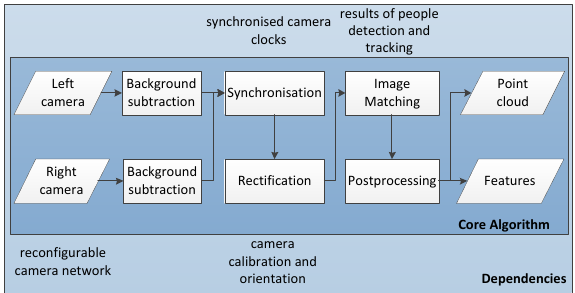
Figure 2: Imaging geometry in monocular and stereoscopic case. Figure 1: Core algorithm and external dependencies. offset between the images would lead to different poses of the al., 2009), classification of observed people into either salient or person in the left and right frame hindering image matching or unremarkable and dynamical reconfiguration of the camera net- leading to errors in depth calculation. To retrieve corresponding work (J¨anen et al., 2011). All of these components are investi- images, their timestamps, written to the image header on the cam- gated in the joint research project CamInSens 1 . era when the image is actually captured, are compared and only nearest neighbours are selected as candidate pairs. The cameras’ clocks are synchronised with the same NTP server to avoid off- 3 METHOD sets. Moreover, the difference between adjacent timestamps has to fall short of a threshold of one frame, i.e. 0 . 06 s given a frame rate of 15 fps . As a result of this synchronisation procedure only a subset of images is actually processed which reduces the ac- tual frame rate and leads to variable offsets between